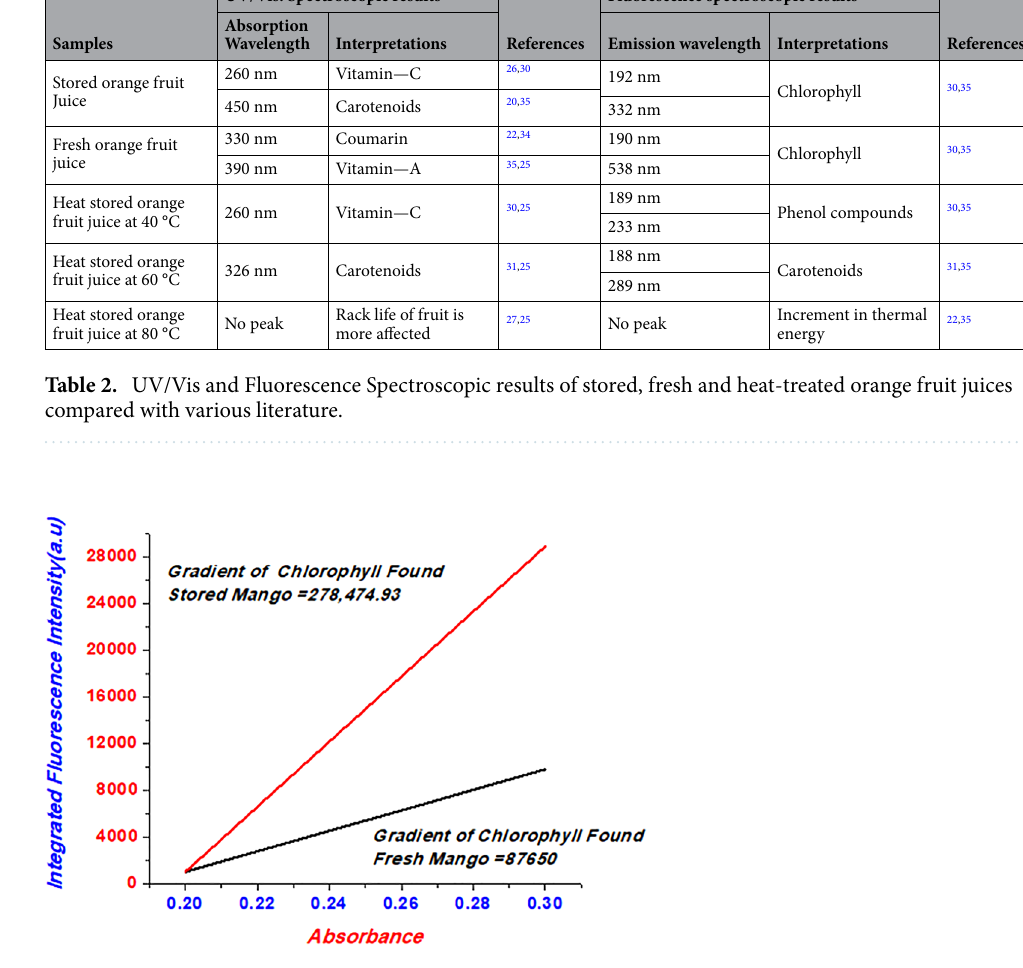
Figure 6. Slope of juices samples corresponding to samples of Fluorescence quantum yield chlorophyll observed in Mango